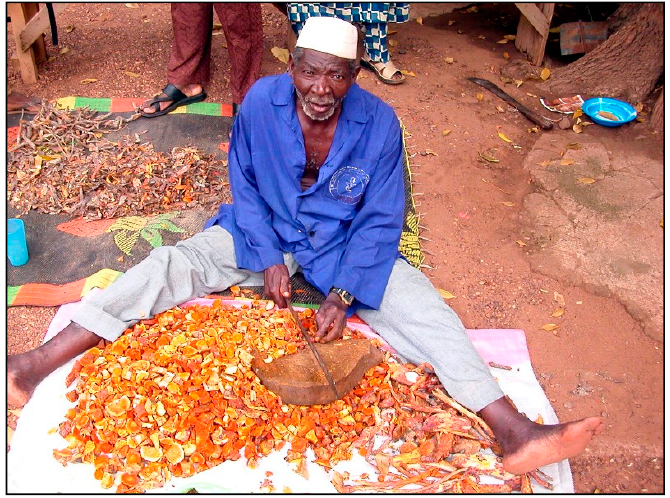
Figure 7. Dried tuberous root of Cochlospermum tinctorium being prepared to be sold at a market in Bamako, Mali, West Africa. Photo used with permission. Copyright Sergio Giani, Archives d’Aidemet